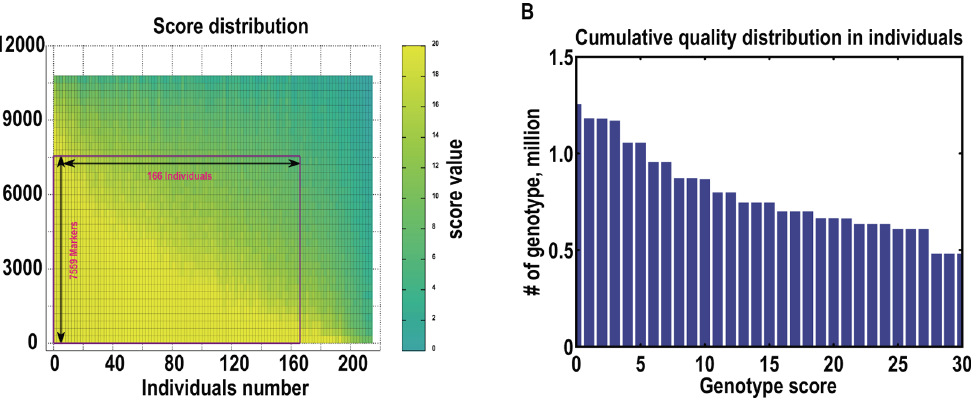
Figure 3. Genotyping quality in common F1 population. The genotyping quality score was used to select qualified markers and individuals for subsequent analysis. This is a dynamic optimization process. We counted low-quality markers for each SLAF marker and for each individual, and deleted the worst marker or individual. We repeated this process, deleting an individual or a marker each time until the average genotyping quality score of all SLAF markers reached the cutoff value, which was 13. (a)Detailed genotyping quality of SLAF-seqdata. (b) Cumulative quality score distribution of 7559 markers in 166 individuals.